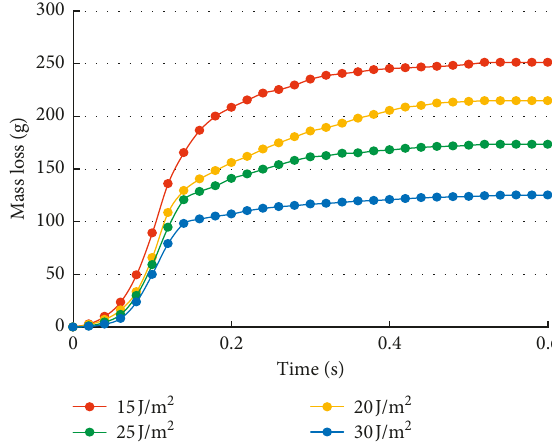
Figure 5: Time-dependent change curves of mass losses under different cohesive forces. Table 3: Mass loss rates under different cohesive forces (g/s).